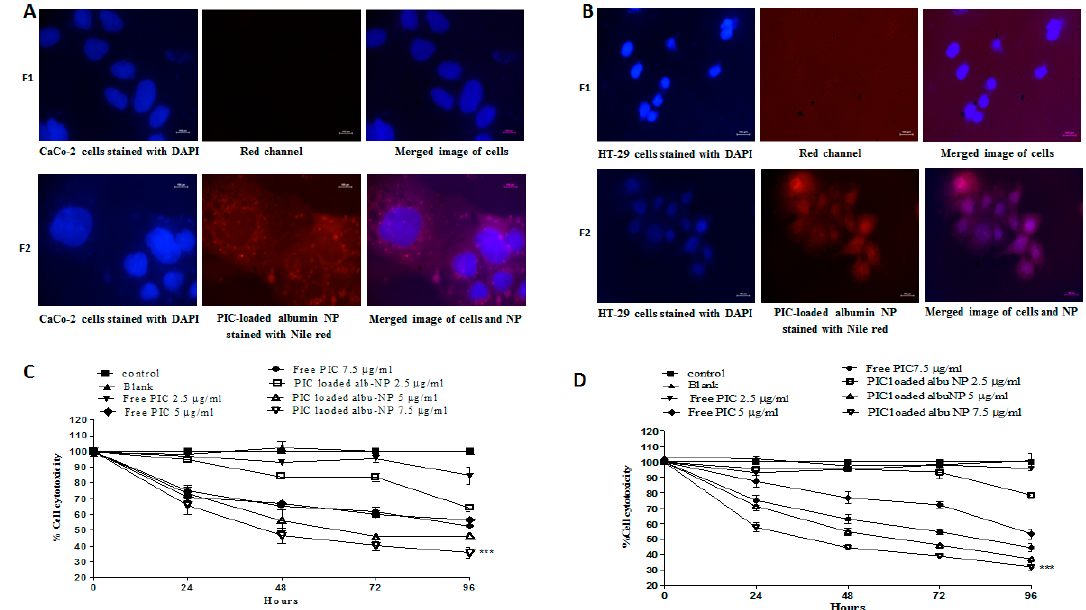
Figure 1. Cellular uptake and in vitro cytotoxicity of PIC-loaded nanoparticle. Cellular uptake of optimized PIC-loaded albumin nanoparticles (NPs) in CaCo-2 and HT-29 cells at 100 × . Cellular localization of Nile red-coated PIC-loaded albumin NPs was observed in CaCo-2 ( A ) and HT-29 ( B ) cells and visualized by overlapping under fluorescent microscopy. The red fluorescent can be observed in the microscopic images F2 in Figure 6A,B. The cytotoxicity assay was evaluated on CaCo-2 ( C ) and HT-29 ( D ) cell lines; 40 × 10 4 cells were seeded on 24-well plates and treated with 2.5, 5, and 7.5 µ g / mL of PIC-loaded albumin NPs and an equivalent amount of free PIC. The absorbance was calculated after 24, 48, 72, and 96 h. PIC-loaded albumin NPs show higher cell cytotoxicity as compared to free PIC. Values are mean ± standard error of the mean (SEM) with n = 3. *** p < 0.001 compared with same amount of free